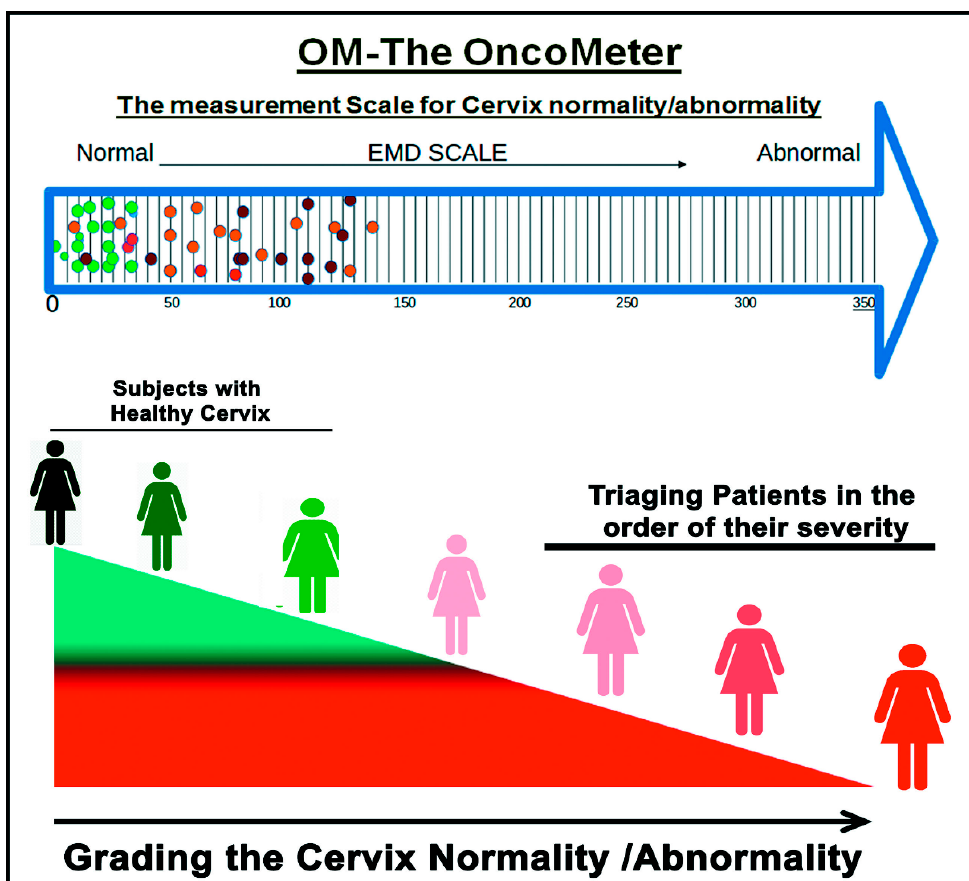
Figure 4. Development of OM—The OncoMeter for triaging of subjects/patients with cervical can-